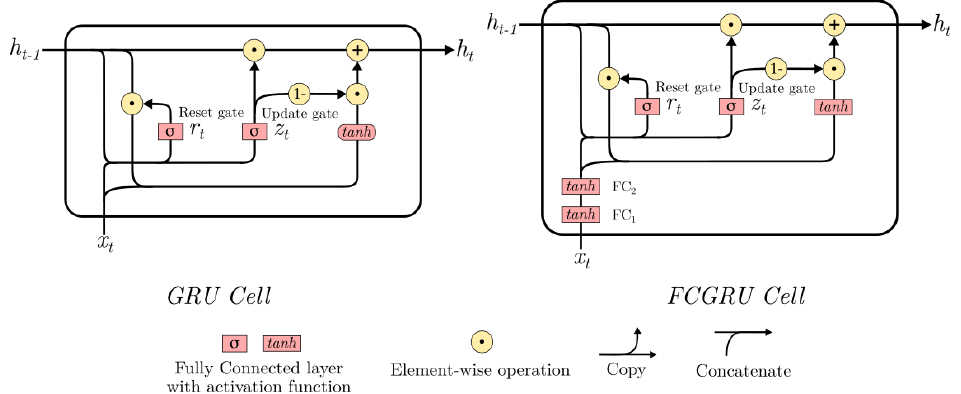
Figure 7. Visual representation of the GRU and FCGRU